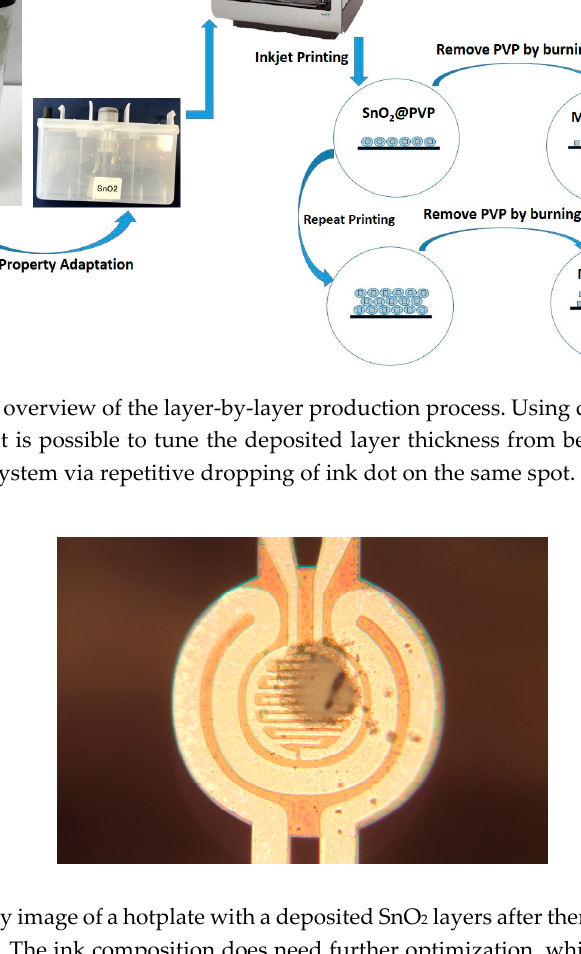
Figure 2. Microscopy image of a hotplate with a deposited SnO 2 layers after thermal treatment to burn the polymer matrix. The ink composition does need further optimization, which is evident from the satellite dots and the inhomogeneous SnO 2 layer